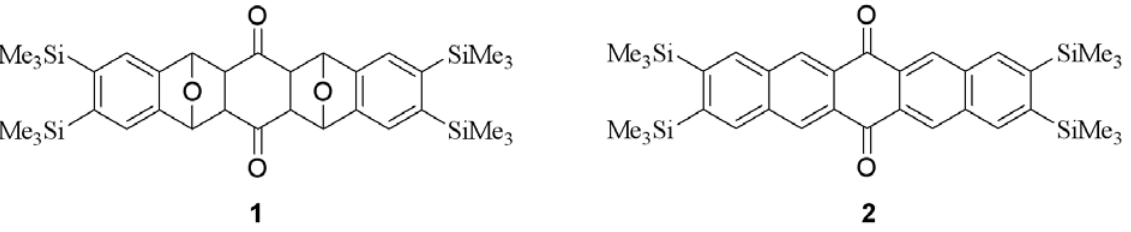
Fig. 1 The chemical structures of compounds 1 and 2